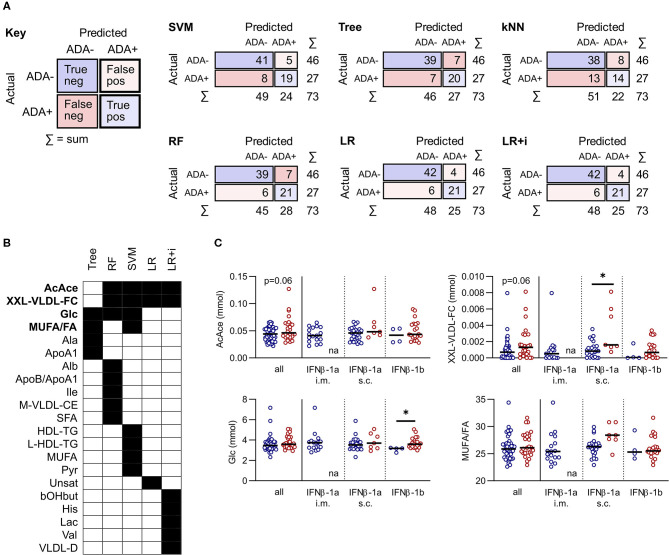
Comparison of predictive model performance at M3. (A) Confusion matrices for six predictive models at month 3 (M3): support vector machine (SVM), decision tree (Tree), k-nearest neighbors (kNN), random forest (RF), and lasso logistic regression (LR) with and without interactions (i). (B,C) A comparison of the metabolites selected by each machine learning model. For RF and SVM only metabolites within the top 10 predictors are included. Metabolites selected by more than one method are highlighted in bold and shown as dot plots in (C). The dot plots compare ADA– to ADA+ altogether (left), or by stratified by treatment (right). Line shows the median. Statistical significance was determined by the Mann-Whitney U, or the Kruskal-Wallis test followed by Dunn's test for multiple comparisons to compare ADA– and ADA+ within treatment subgroups; *p < 0.05; na, non-applicable.